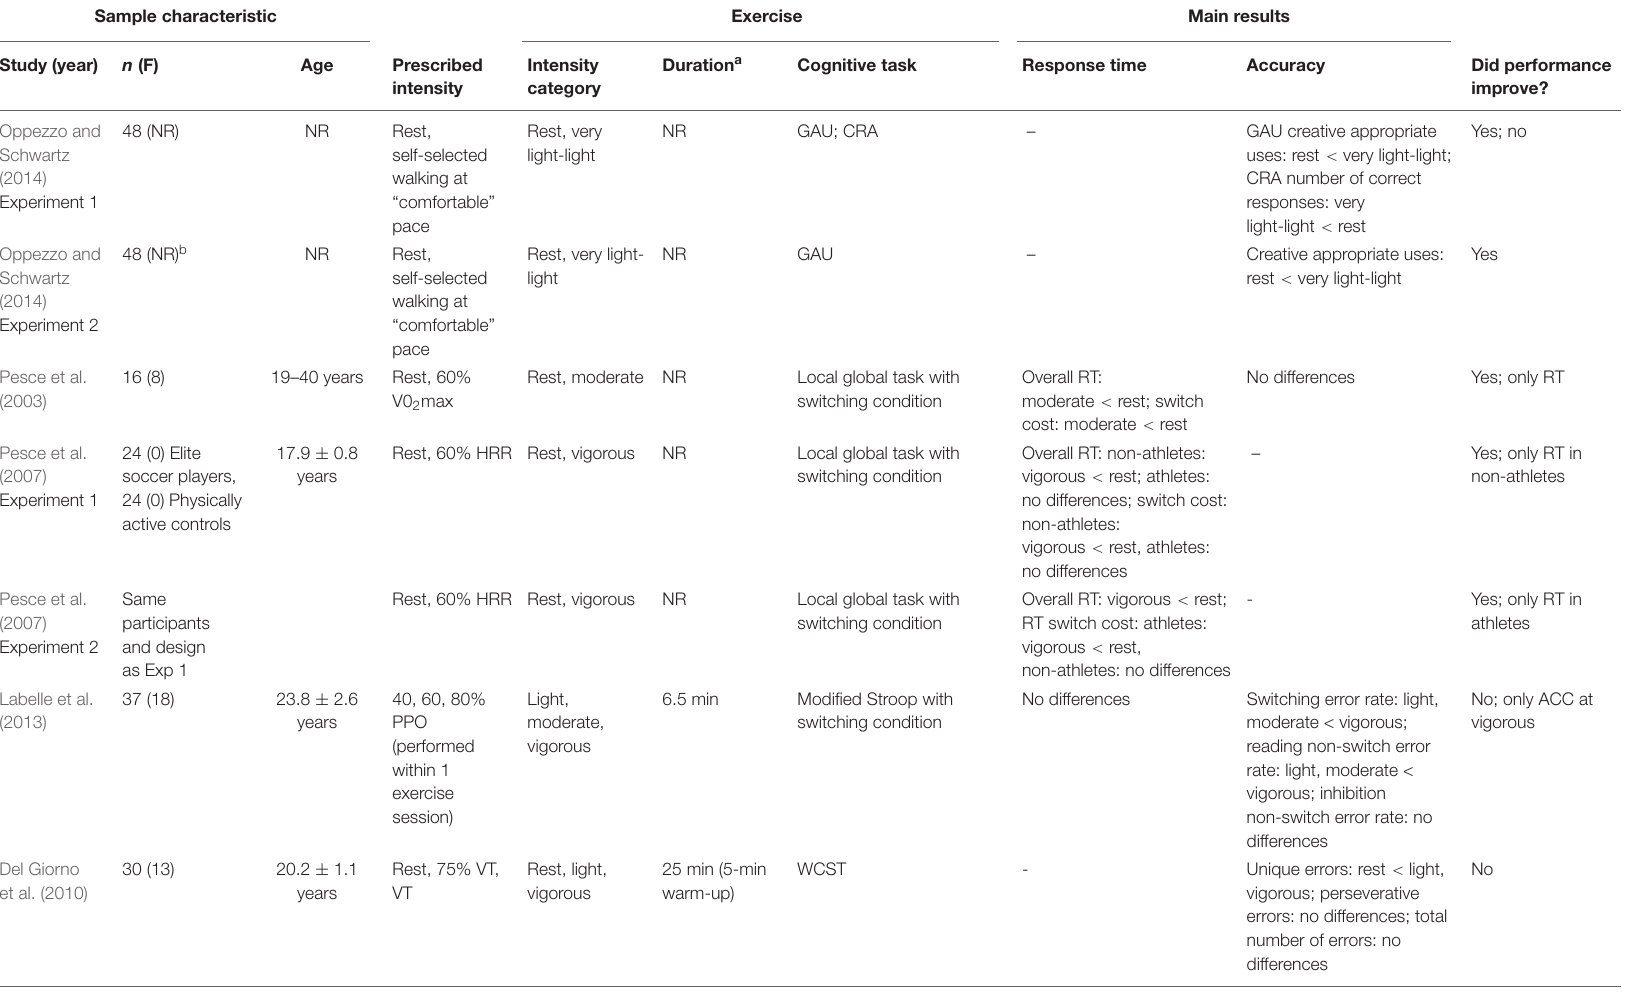
TABLE 3 | Summary of studies examining cognitive flexibility during acute aerobic